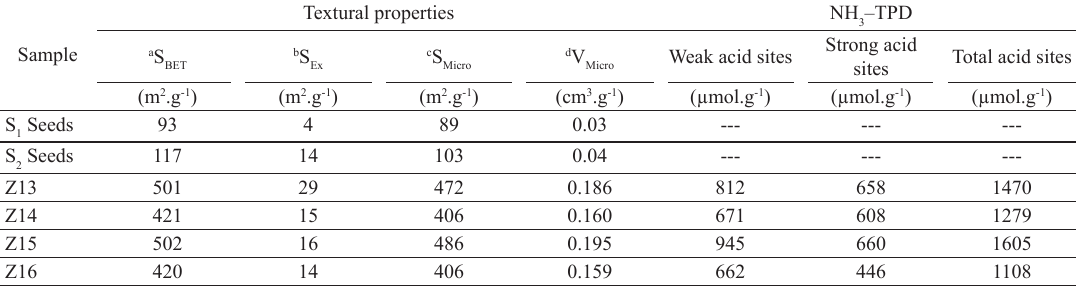
Table 3. Textural and acidic properties of the seeds and zeolite SSZ-13 samples.